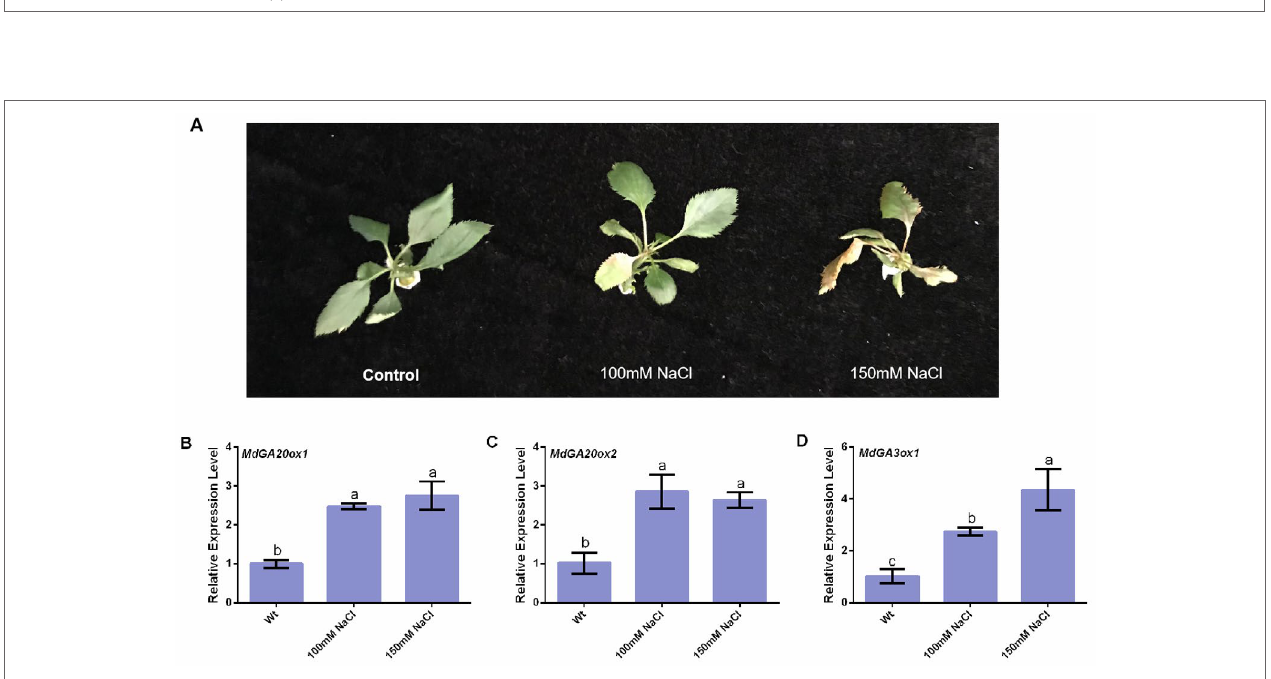
FIGURe 5 | Responses of MdGA20ox1 , MdGA20ox2 , and MdGA3ox1 to NaCl stress in wild-type “Gala2” tissue-cultured apple seeding. (A) Morphology of the treatment apple seedings under salt stress. (B – D) Transcript levels of MdGA20ox1 , MdGA20ox2 , and MdGA3ox1 in “Gala2” tissue-cultured seeding under salt stress. Data are shown as means ± SE of three independent experiments. Different letters indicate significant differences at p < 0.05.